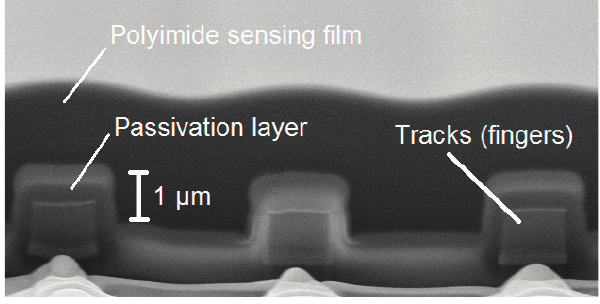
Figure 4. Cross-section for three of the sensing capacitor’s fingers in [15] sectioned by focused ion